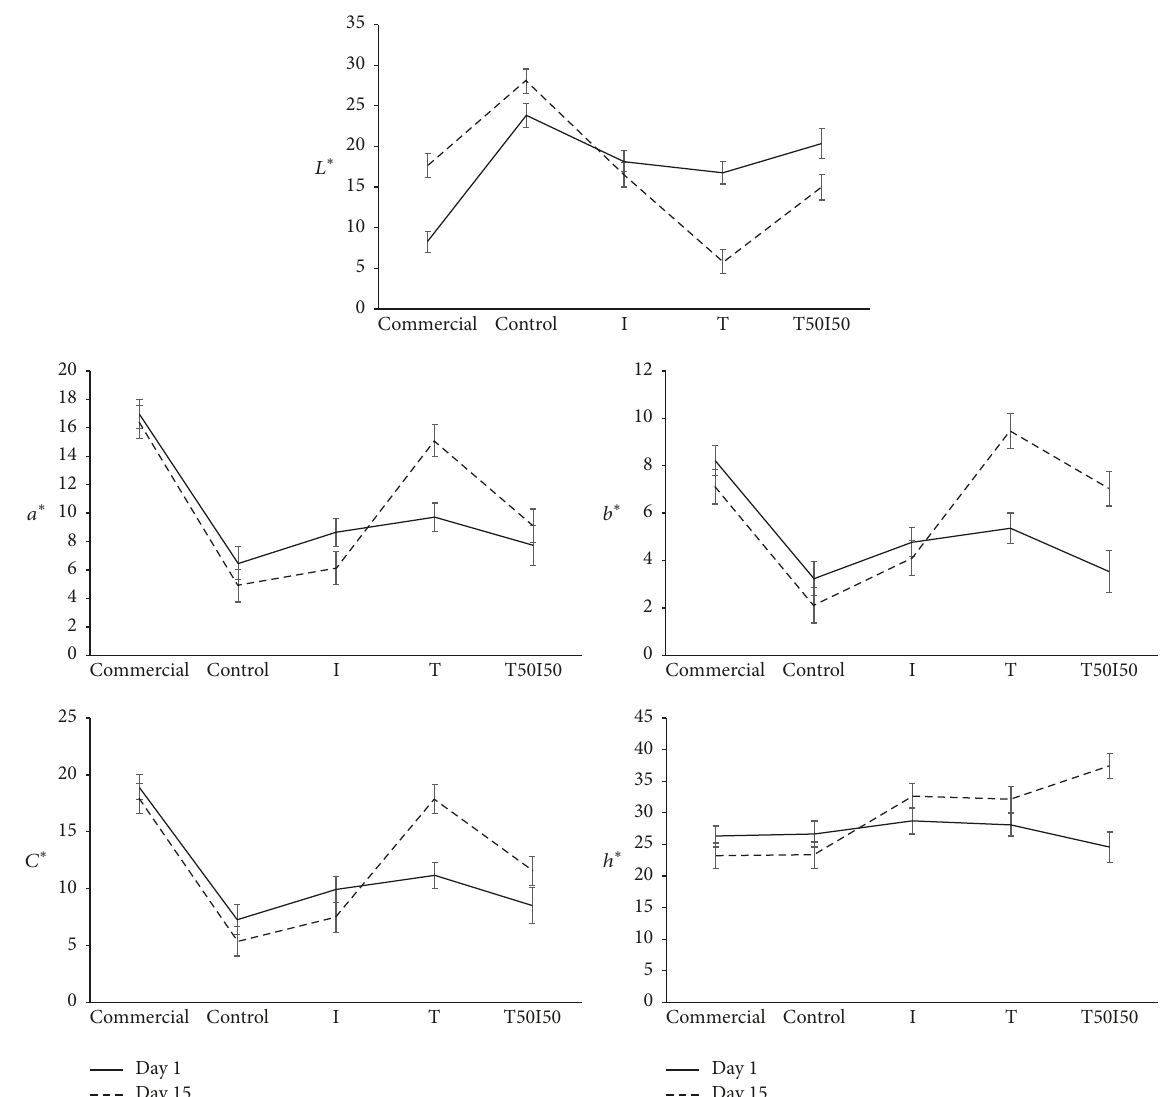
Figure 3: Interaction graphics ( 𝛼 = 95 %) of colour parameters: 𝐿 ∗ , 𝑎 ∗ , and 𝑏 ∗ coordinates, Chroma ( 𝐶 ∗ ) and hue ( ℎ ∗ ) of the watermelon jelly as a function of the formulation and storage time.